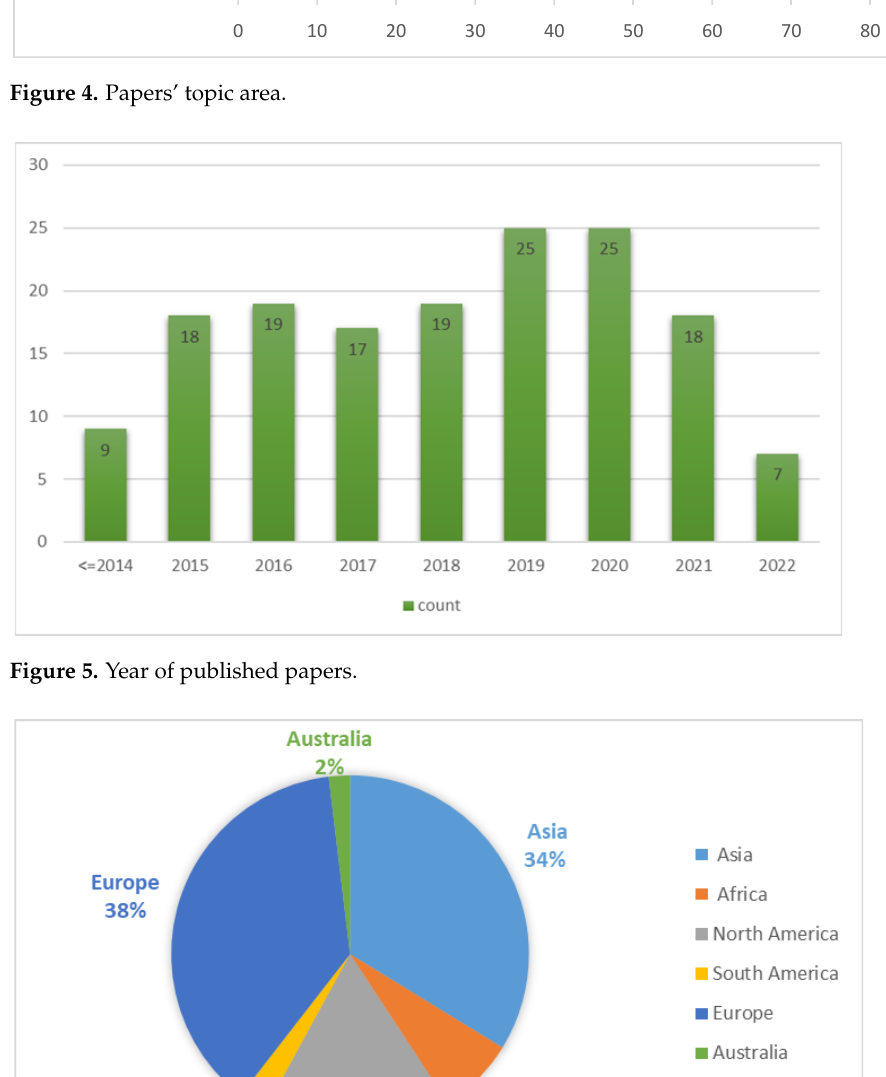
Figure 4. Papers’ topic area .